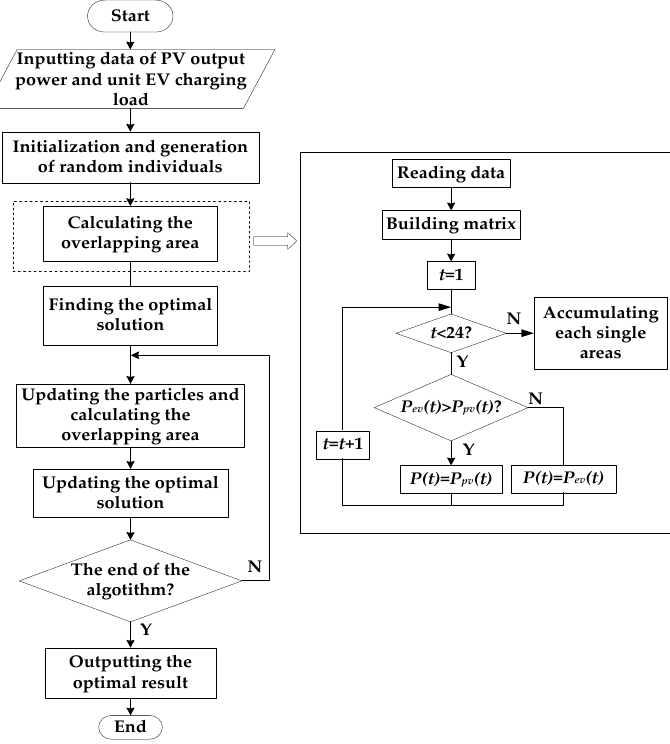
Figure 9. Flow chart of area-calculation-based PSO algorithm.